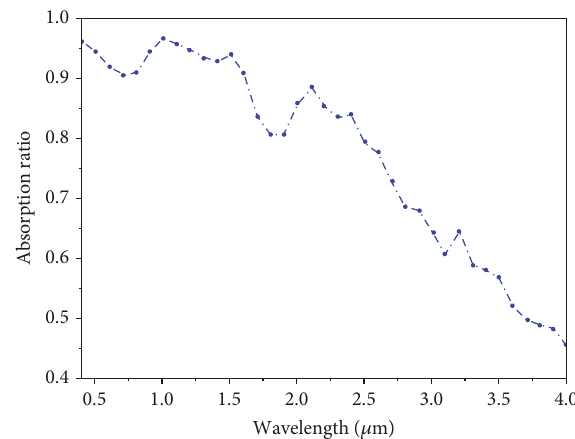
Figure 9: Absorptivity varying curve of sinusoidal surface structure along with wavelength.